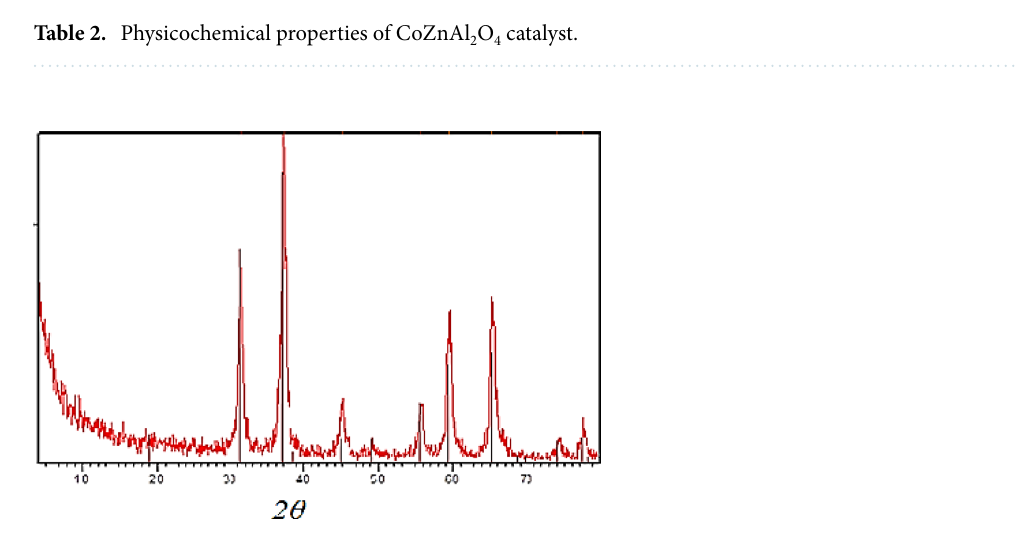
Figure 4. X-ray diffraction of Co/Zn-Al 2 O 4